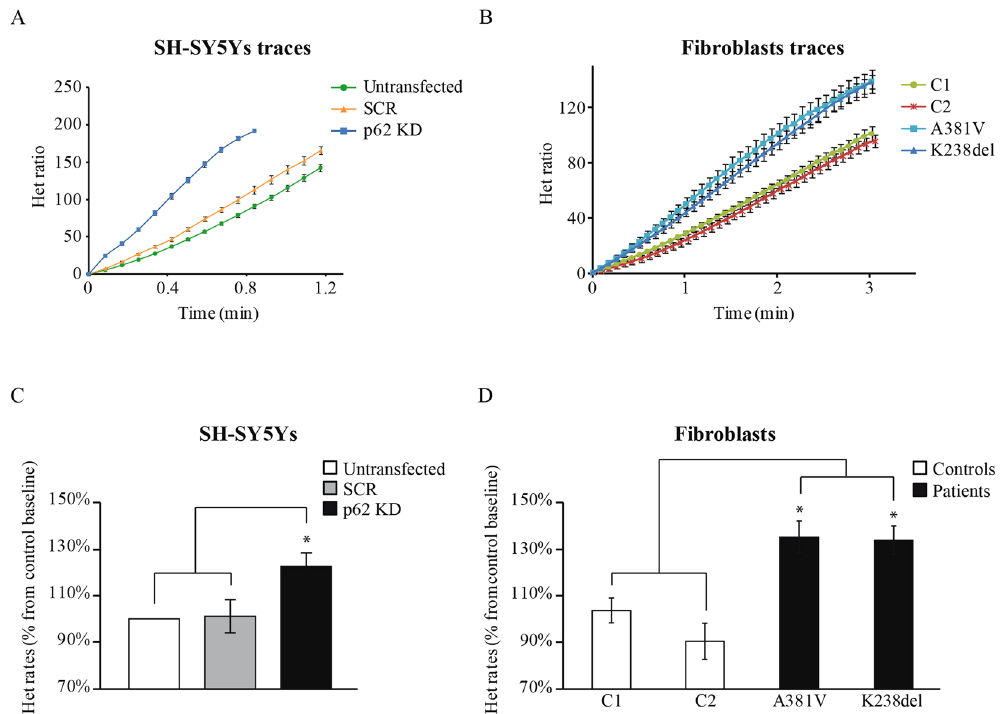
Figure 4. p62 deficiency results in increased oxidative stress. ( A,B ) Cellular oxidative stress was evaluated analysing the oxidation rates of the superoxide indicator dihydroethidium (Het) which initially exhibits cytosolic blue fluorescence and when oxidised, it shows bright red fluorescence in the nucleus. These changes can be detected by live-cell imaging. Time-course representative traces showing the Het oxidation slopes in untransfected, SCR and p62 KD SH-SY5Y cells ( A ) and fibroblasts from control donors and patients carrying the p62 pathogenic mutations mentioned above ( B ). In all cases the traces represent the mean of at least 20 cells on a single coverslip ± SEM. ( C,D ) Het oxidation rates from untransfected, SCR and p62 KD SH-SY5Y cells ( C ) and control and p62 mutant fibroblasts (D) . Rates were calculated as the change in fluorescence over a period of time and are expressed as percentage of a basic rate. Data represent the mean of at least 3 independent experiments ± SEM. In all cases * indicates p < 0.05 compared with the values in control